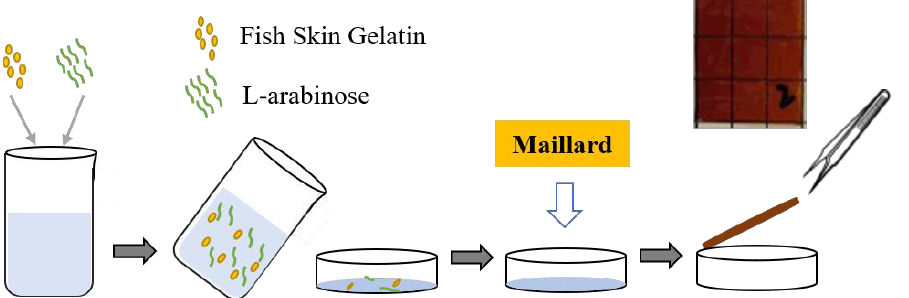
Figure 1. Preparation flow chart of Maillard-modified fish skin gelatin/L-arabinose (FG-Ara) com- posite films.